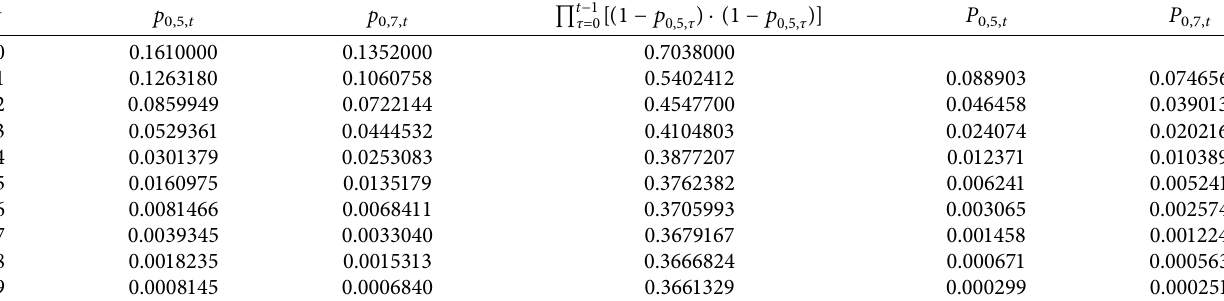
Table 12: Related probabilities for node 0 in Figure 2.